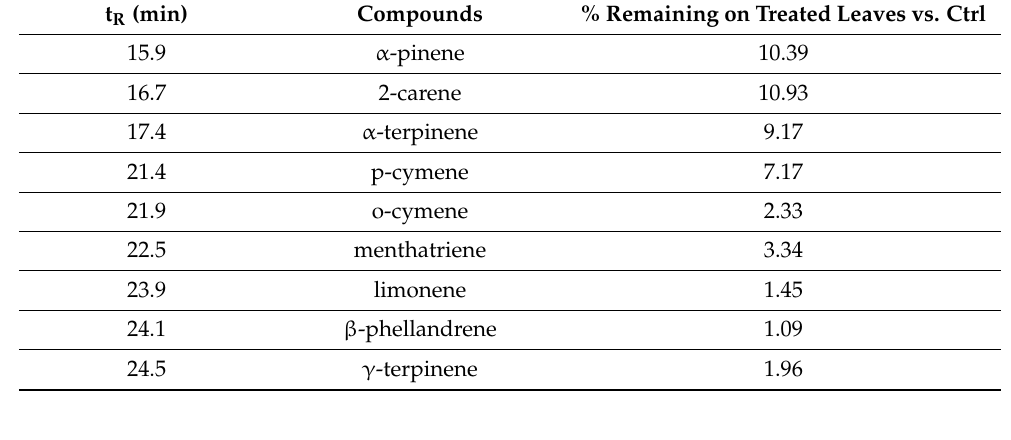
Table 6. VOCs produced by S. lycopersicum identified using SPME-GC/MS.